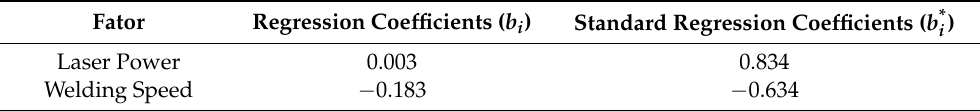
Table 5. Standard coefficient for multiple linear-regression